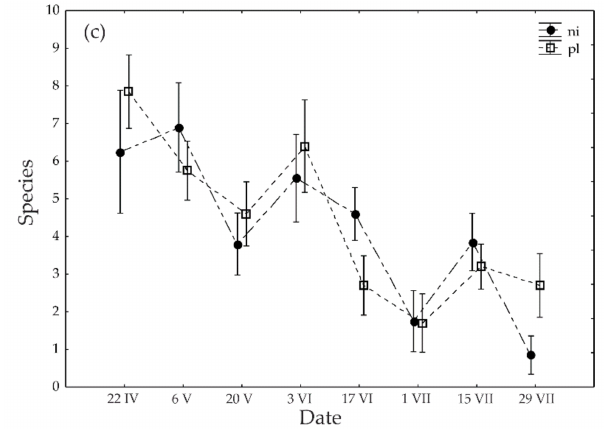
Figure 1. Average abundance ( a ), species diversity ( b ), and species richness ( c ) of spiders depended on studied soil tillage (ni-non-inversion and pl-ploughed) in cereals fields (the vertical lines indicate 0.95 confidence interval).